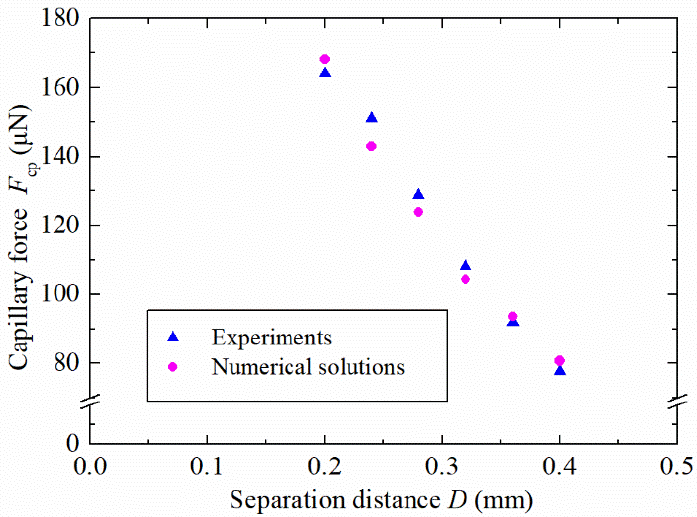
Figure 10. Comparation results between the numerical solutions and experiments.